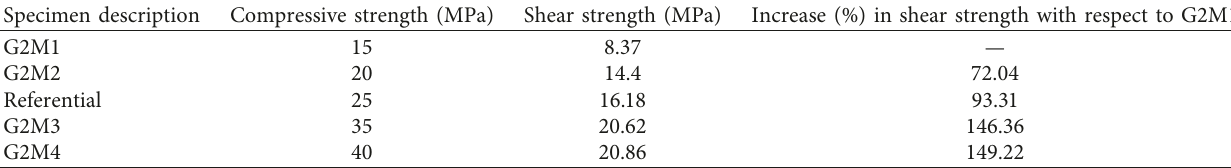
Table 9: Shear strength response of specimens with different compressive strengths.